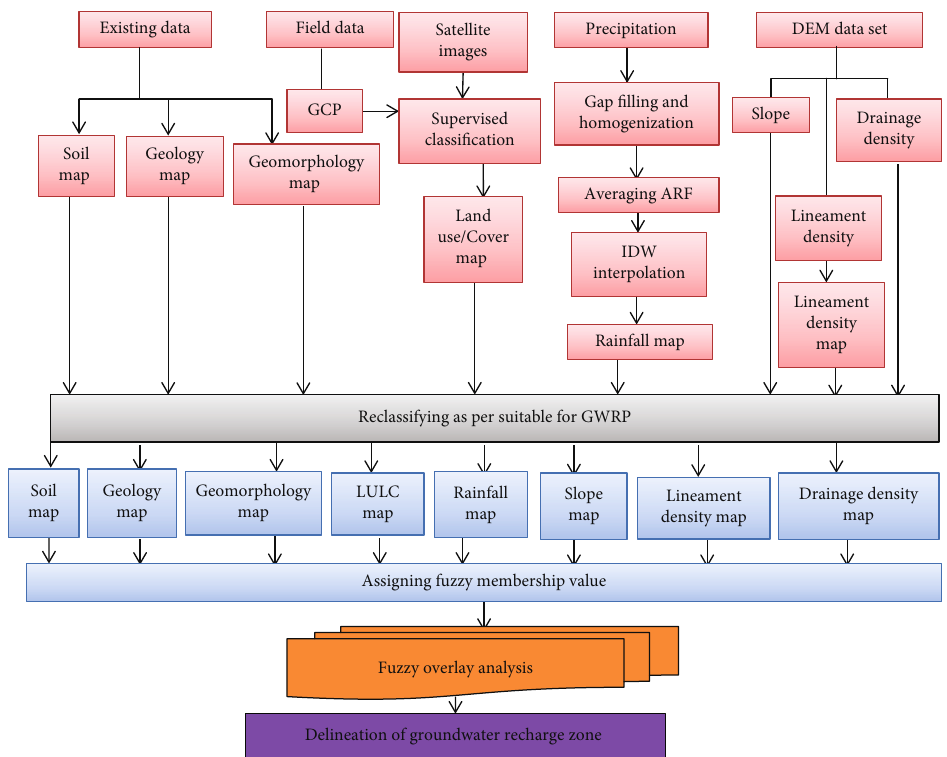
Figure 2: Flowchart for delineating the groundwater recharge potential zone.